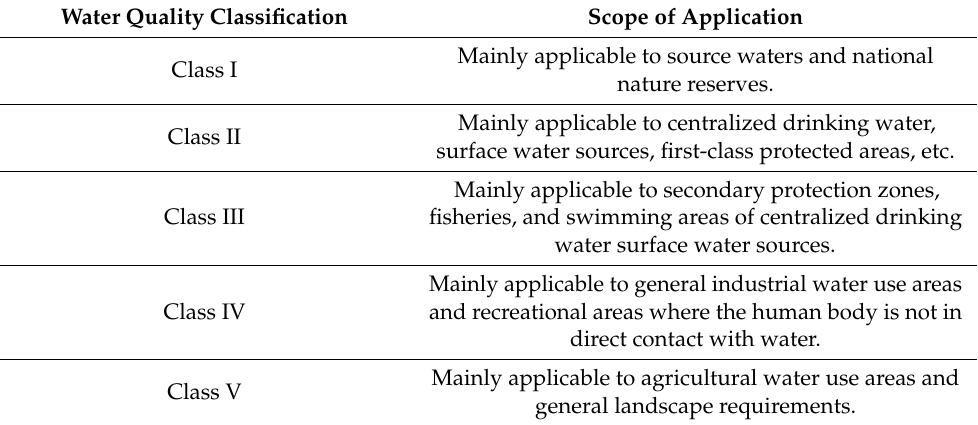
Table 1. Water function and standard